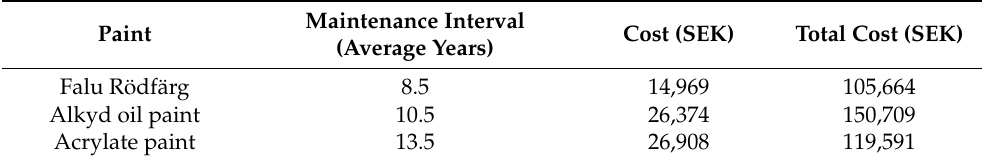
Table 4. Maintenance interval and total costs of a painted wooden facade over its working life done by private